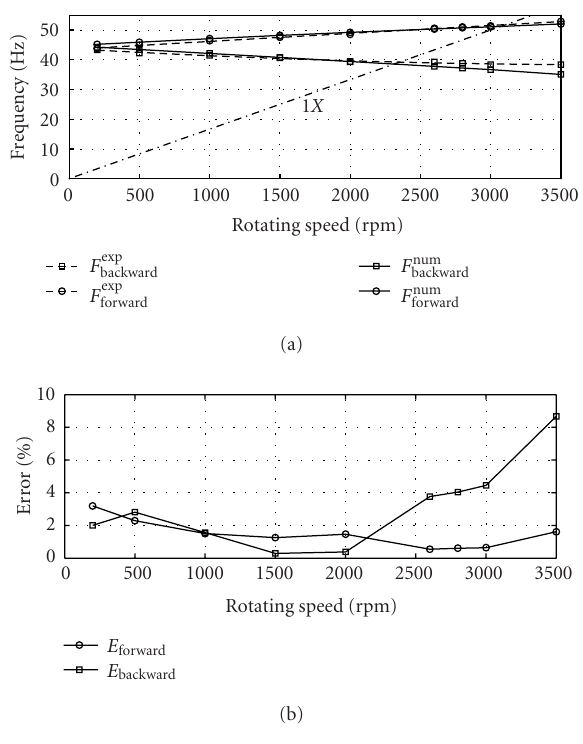
Figure 25: Comparison between the experimental and numerical Campbell diagrams for the configuration C